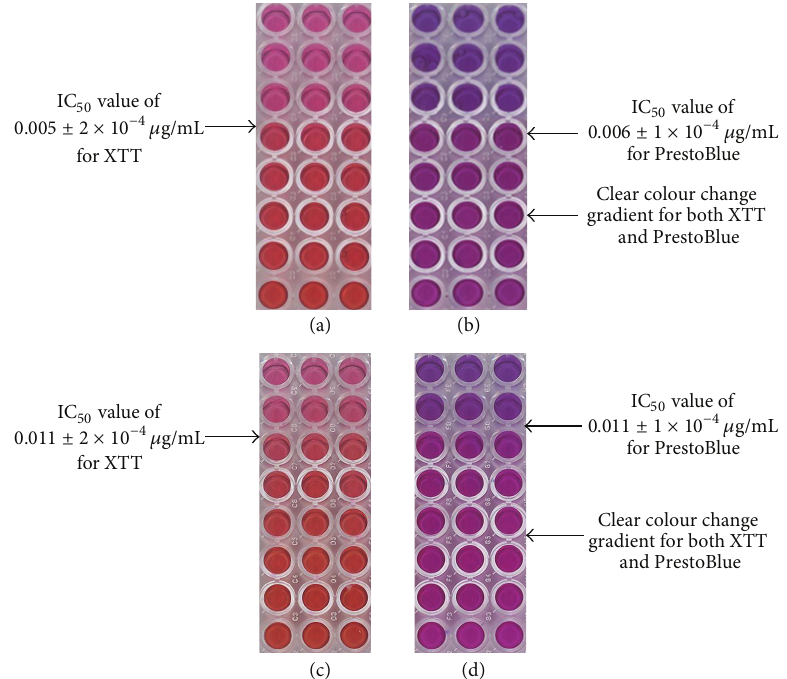
Figure 3: Comparison of different growth indicators on various cell lines (a) XTT on HeLa cells, (b) PrestoBlue on HeLa cells, (c) XTT on A431 cells, and (d) PrestoBlue on A431